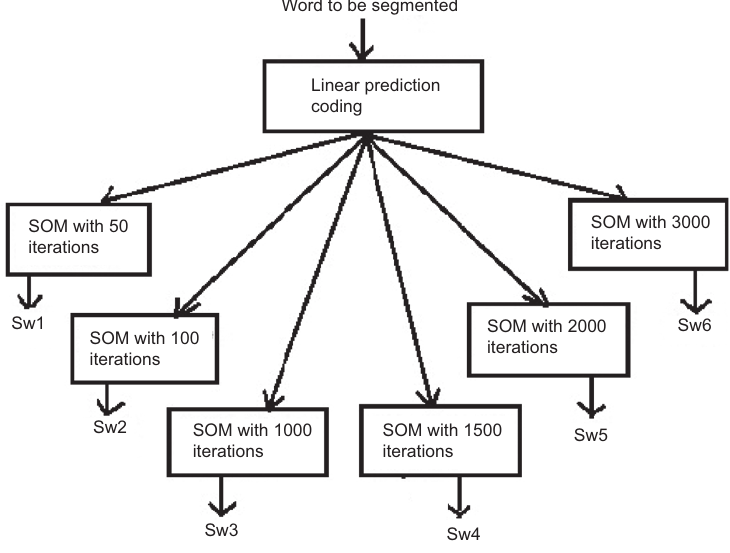
Figure 3. SOM Segmentation Block.